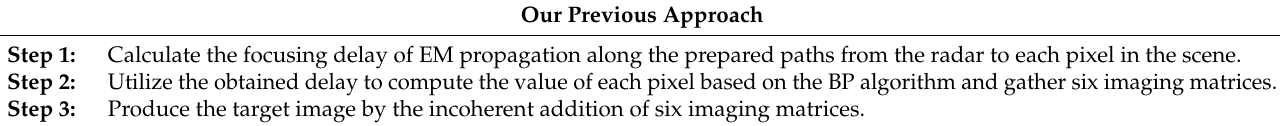
Table 1. A brief description of the previous